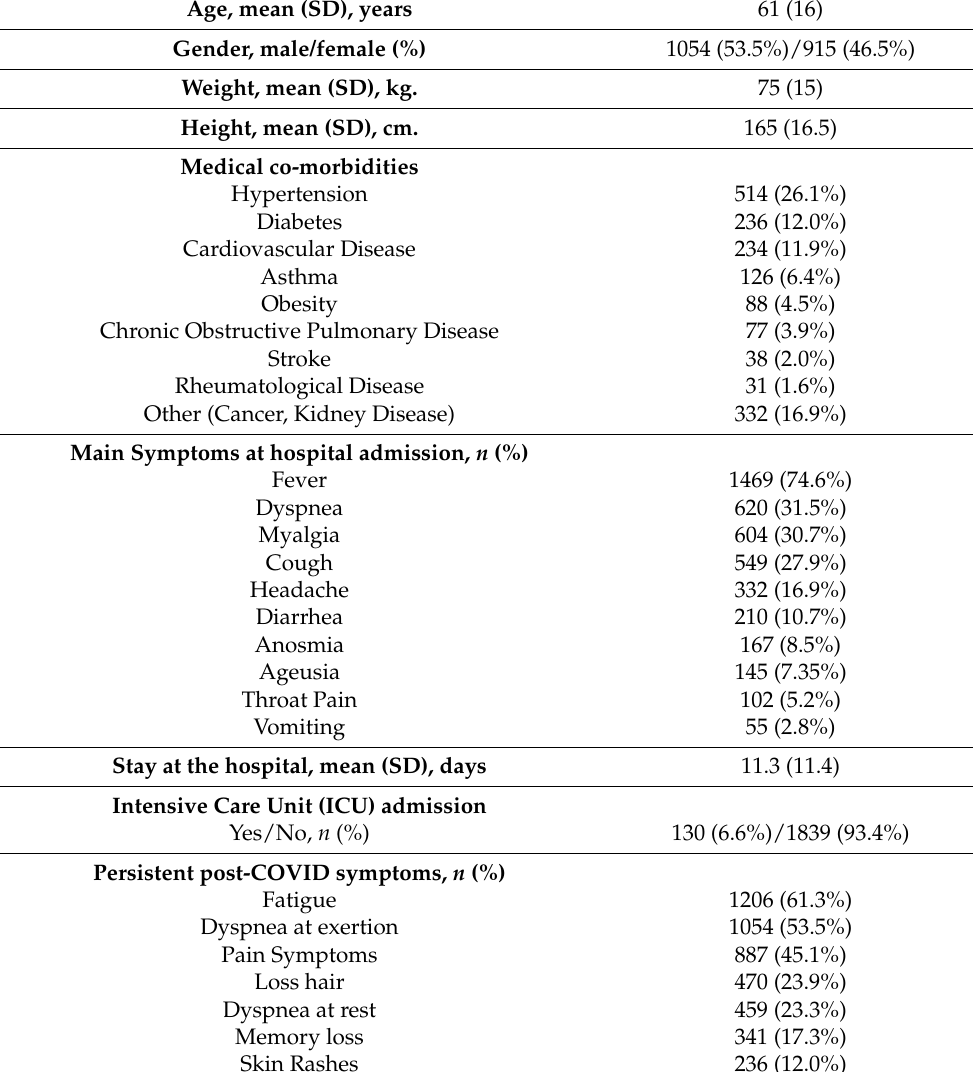
Table 1. Clinical/Hospitalization Data and Post-COVID Symptoms ( n = 1969). Age, mean (SD), years 61 (16) Gender, male/female (%) 1054 (53.5%)/915 (46.5%) Weight, mean (SD), kg. 75 (15) Height, mean (SD),